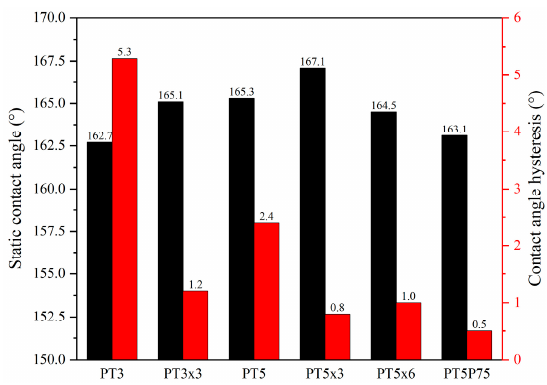
Figure 4. Static contact angle and contact angle hysteresis before icing / de-icing cycles.